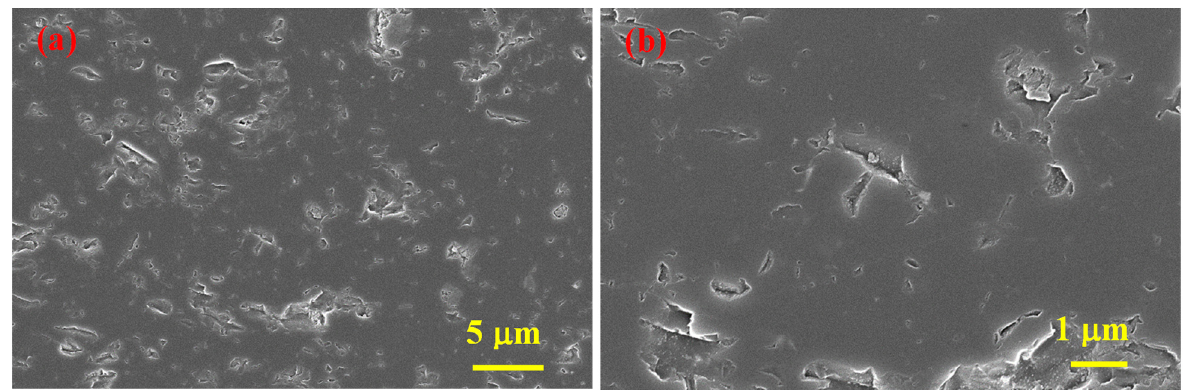
Figure 6. SEM micrographs of the vertical cross-section of SPS consolidated B 4 C at two magnifications ( a , b ), sample 5.